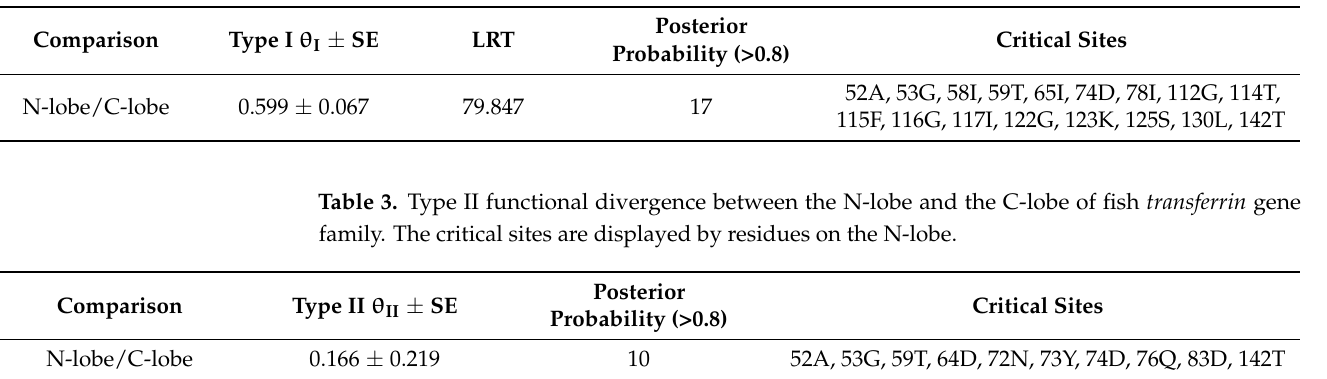
Figure 4. Motif distribution of N-lobe and C-lobe of TF proteins. Sequence logos of six conserved motifs are also shown here. Four iron-binding residues are marked with red stars, and two anion binding residues are marked with green stars. The size of the letter represents the degree of conservation of the amino acid. The larger the letter, the more conservative the amino acid.